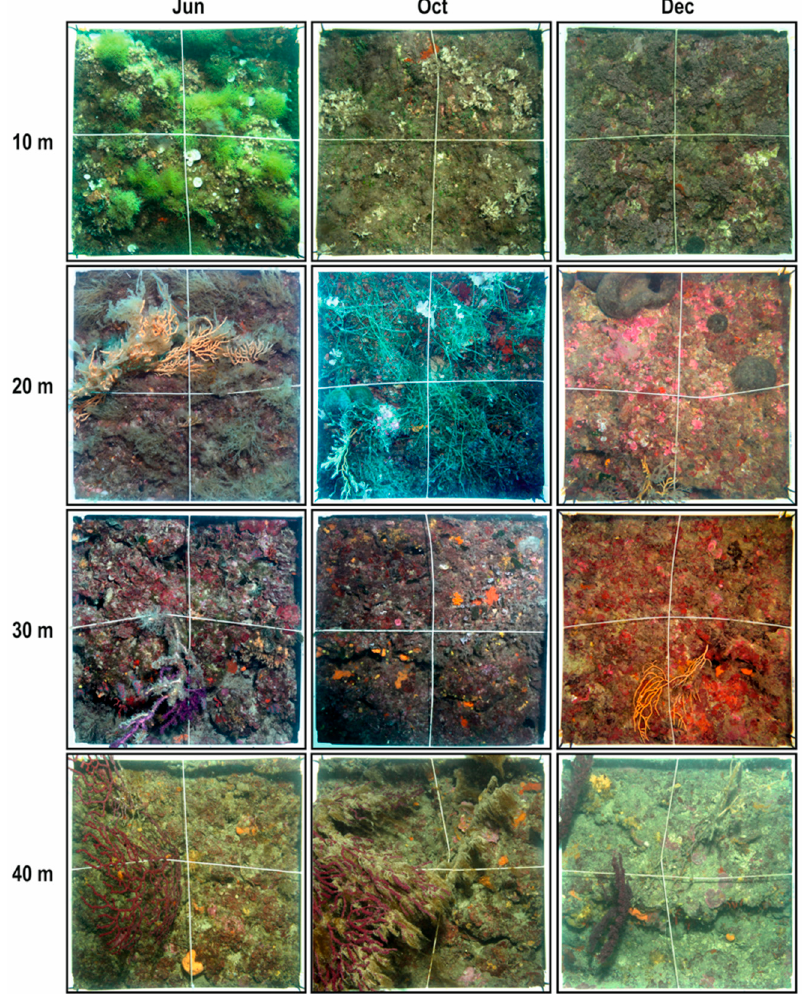
Figure 2. Examples of photoquadrats (each covering an area of 50 × 50 cm 2 ) carried out at three times (June, October, and December) and at four depths (10 m, 20 m, 30 m, and 40 m).